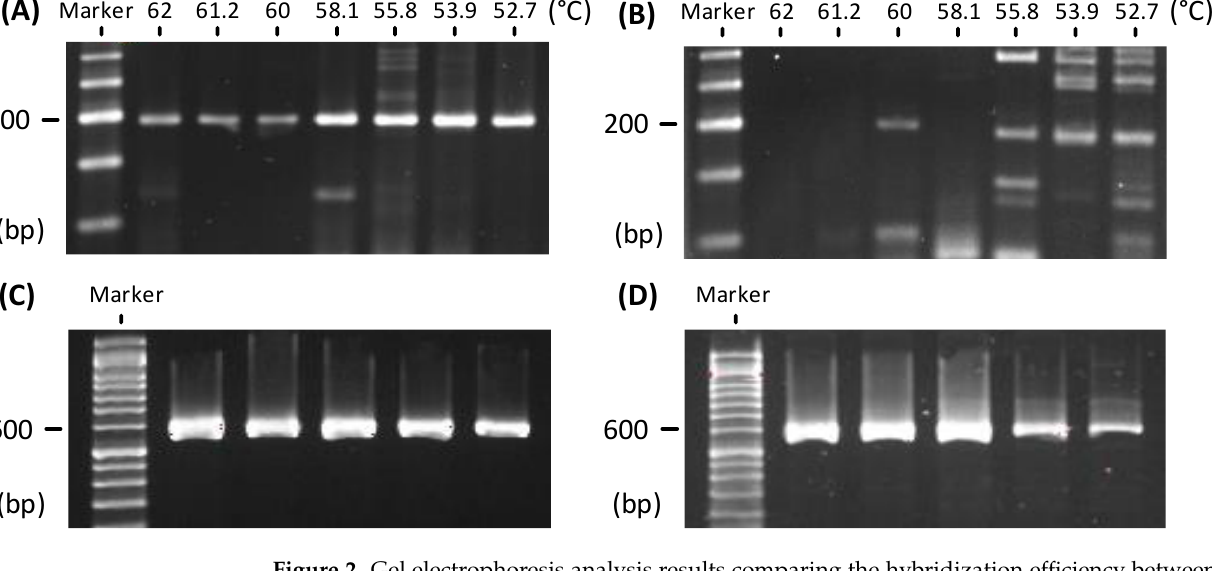
Figure 2. Gel electrophoresis analysis results comparing the hybridization efficiency between the extracted target dsDNA and the P35S primer at various temperatures. ( A ) dsDNA extracted from GMS, ( B ) dsDNA extracted from OS, ( C ) confirmation of the target dsDNAs extracted from GMS containing the soybean gene fragment Rbcl, ( D ) confirmation of the dsDNA extracted from OS containing the soybean gene fragment Rbcl.